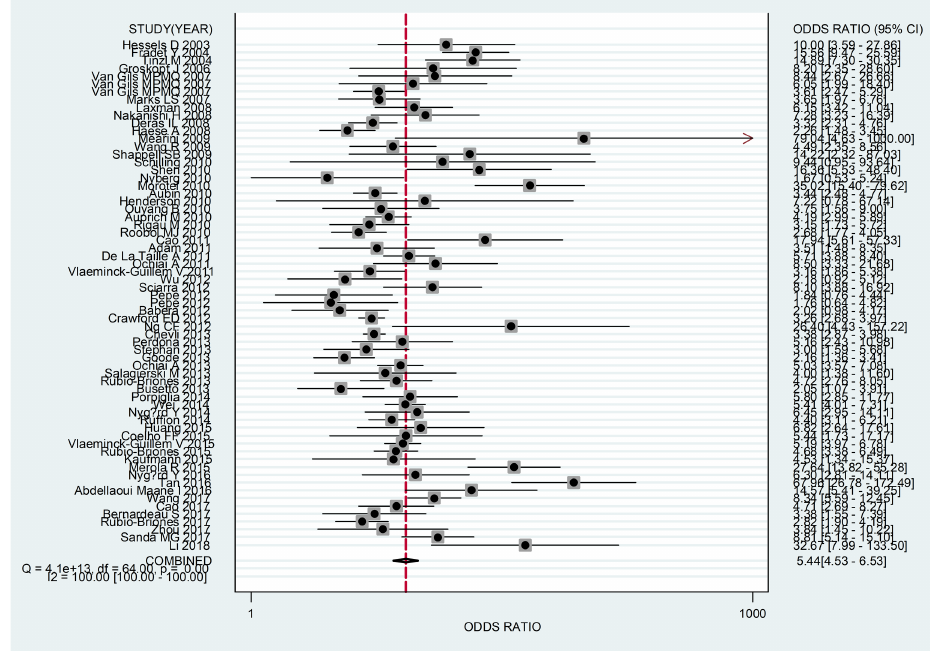
Figure 3 - Forest plots of summary diagnostic odds ratio of by PCA3 as a diagnostic marker for PCa in this meta-analysis. Each solid circle represents an eligible study. The size of solid circle reflects the sample size of each eligible study. Error bars represent 95% CIs.